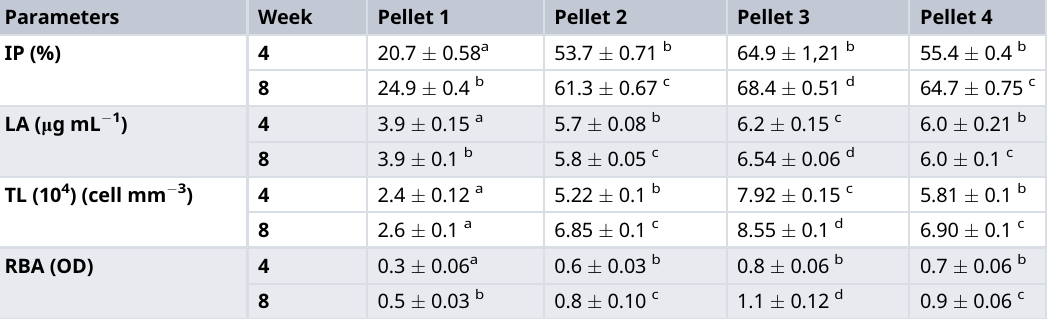
Table 3. Immunological parameters (RBA, IP, LA, and TL) at Weeks 4 and 8 of goldfish treated with Boesenbergia pandurata extract (BPE). Parameters